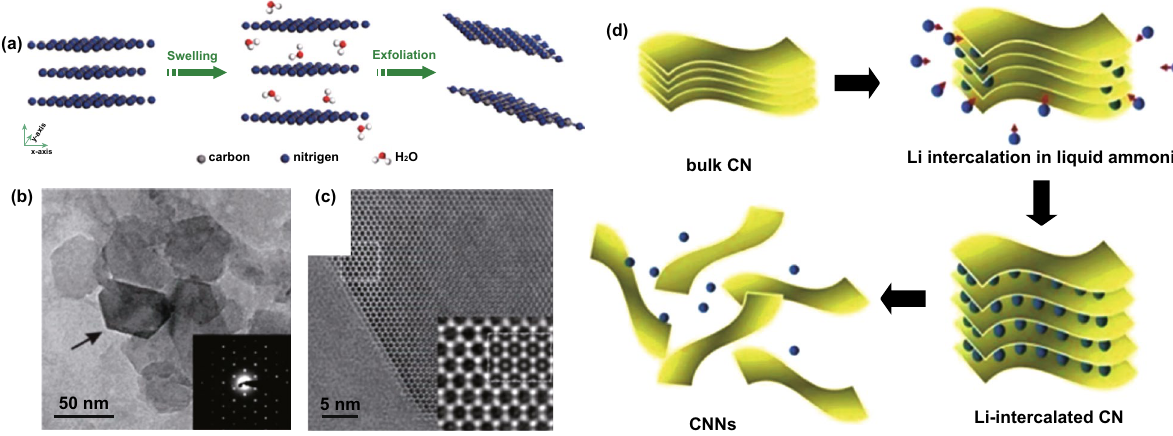
Fig. 11 a Schematic illustration of liquid-exfoliation process from bulk g-C 3 N 4 to ultrathin nanosheets. Reproduced with permission from Ref. [90]. b TEM image of exfoliated ultrathin nanosheets, c higher magnification of a carbon nitride nanosheet edge viewed along [001]. Repro- duced with permission from Ref. [91] d Schematic diagram of the lithiation and exfoliation of g-C 3 N 4 nanosheets from bulk g-C 3 N 4 . Repro- duced with permission from Ref. [92]. Copyright permissions from American Chemical Society. (Color figure